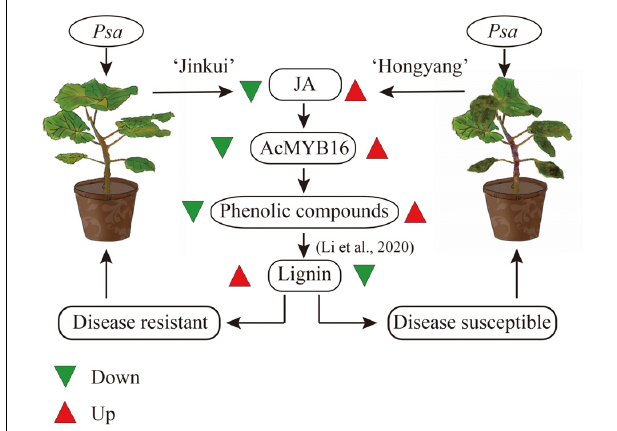
FIGURE 7 | Possible scheme for metabolism following Psa attack in ‘Jinkui’ and ‘Hongyang’ leaves.